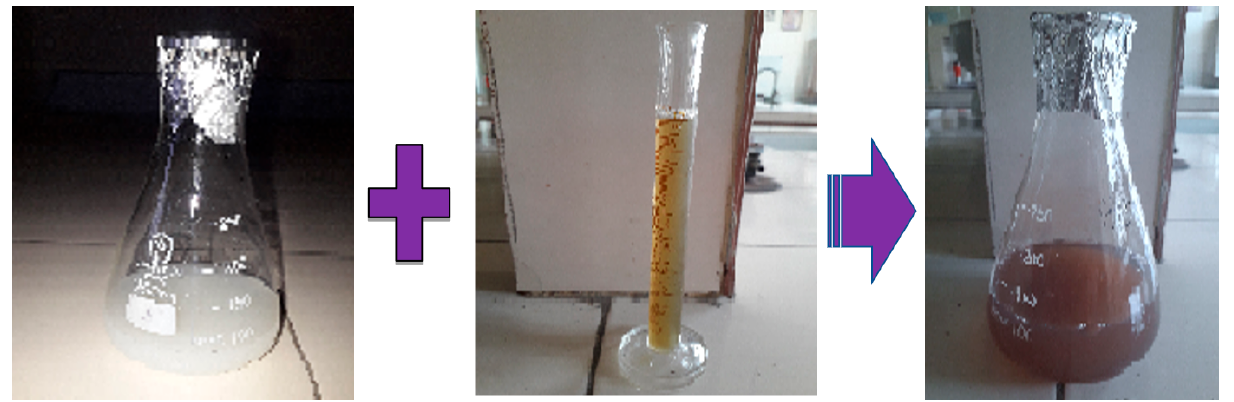
Figure 2. Synthesis of AgNPs using sugarcane extract.